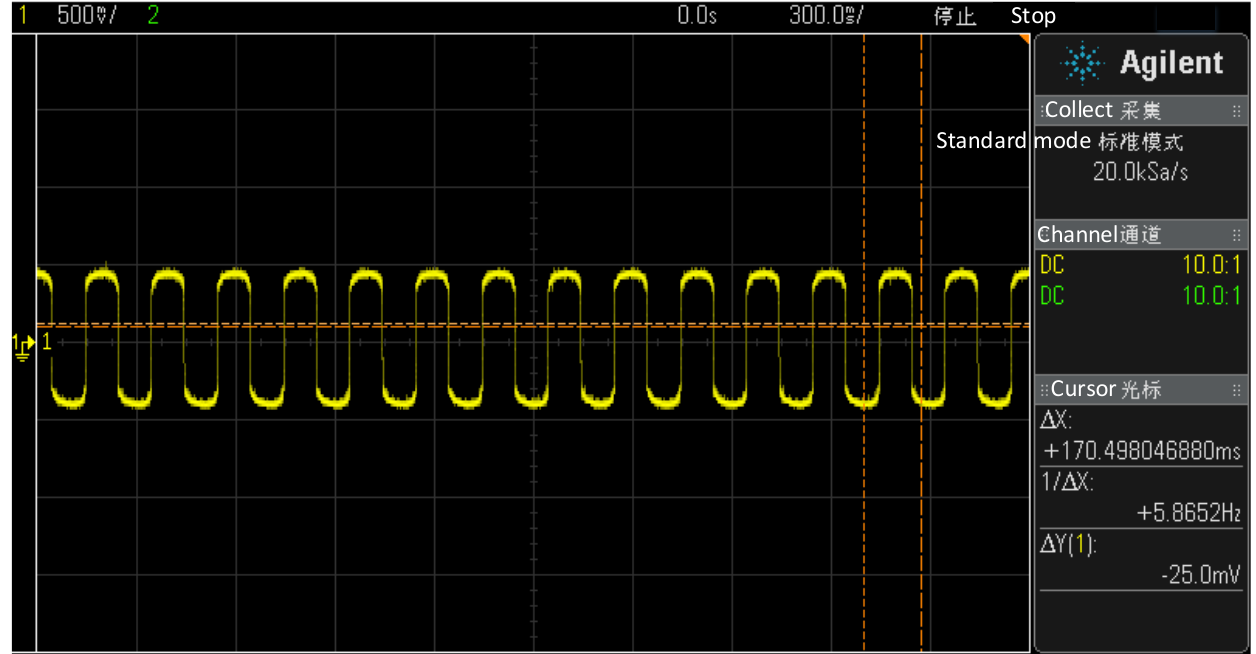
Figure 16. Curve of voltage output.